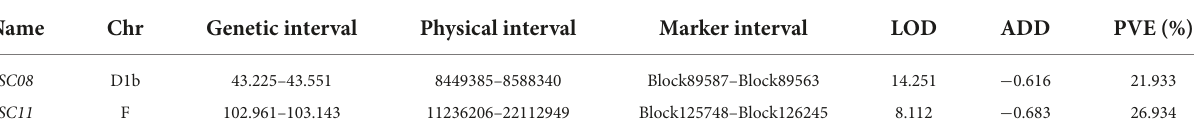
TABLE 2 Two QTLs for seed coat color in RIL